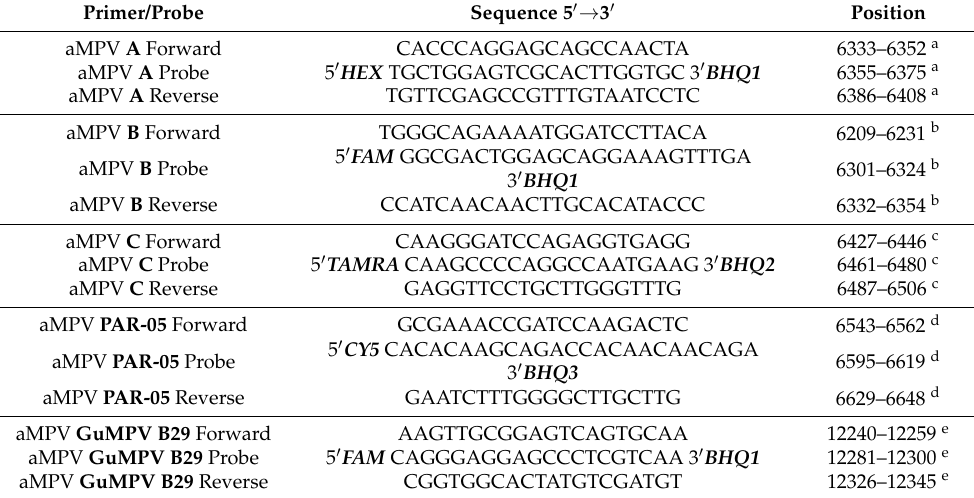
Table 1. Primers and probes designed for the multiplex real time RT-PCR assays detecting the various aMPV subtypes. Primers and probes were designed using reference sequences ( a subtype A Acc. Num. MF093139.1; b subtype B Acc. Num MN729604.1; c subtype C Acc. Num.